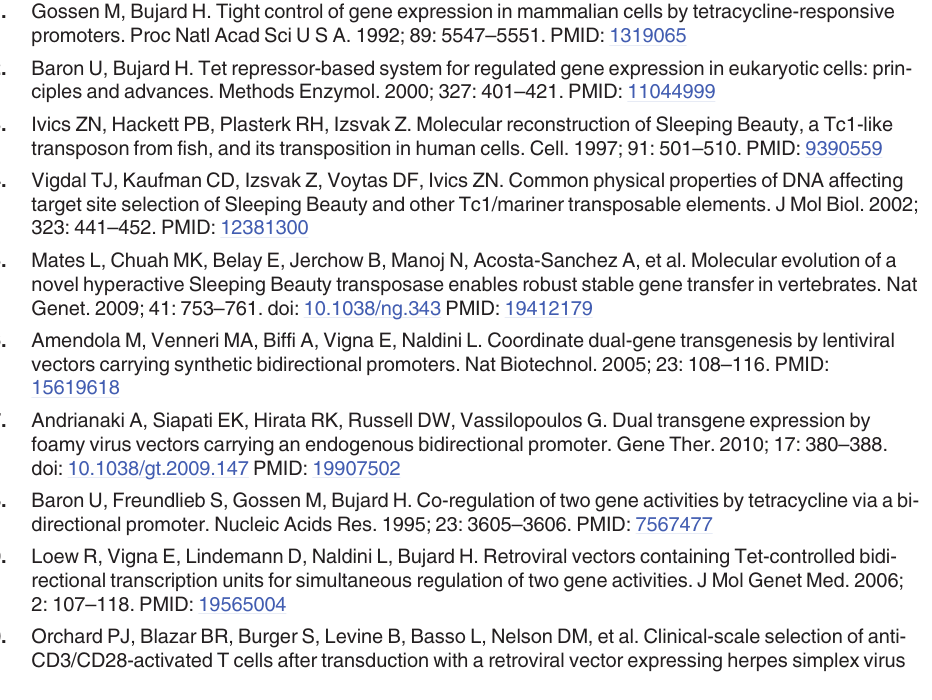
S3 Fig. Tet-responsive activity of the HSV-IE promoter. Overlay of flow cytometry histo- grams for the seven “ optimal ” clones generated using G-IE-N(TR TATA ) demonstrating GFP ex- pression in the absence (purple, repressed, M1 gate) and presence of 4 μ M doxycycline (orange, de-repressed, M2 gate). The quantified results are reported in Table 3. (TIF) S4 Fig. TetR protein levels in engineered cells. (A) Whole cell protein lysates from either G-IE-N(TR TATA ) or TRP-GFP (2 optimal clones each) were reacted with anti-TetR antibody or GAPDH (loading control). Control lanes show transiently transfected TetR (+ ’ ve) and mock transfected HEK-293T cells (- ‘ ve). M indicates lane loaded with a protein ladder. A vertical line was inserted to represent repositioned lanes on the gel image. (B) Whole cell protein lysates from G-IE-N(TR TATA ) clones representing different expression characteristics were reacted with anti-TetR antibody or GAPDH (loading control). O is optimal; H is heterogeneous; L is leaky; and NI is not inducible. Mock transfected HEK-293T cells (- ‘ ve) served as a TetR negative control.